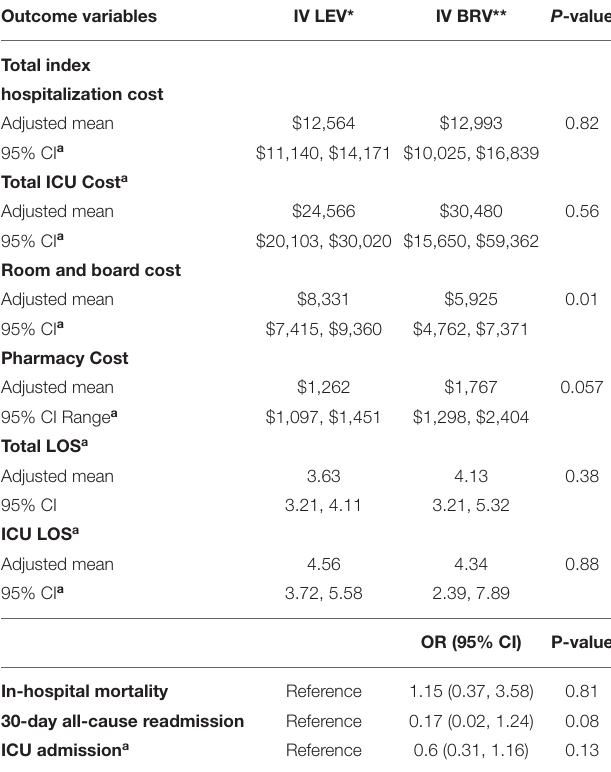
TABLE 4 | Multivariable regression results for outcomes by treatment status. Outcome